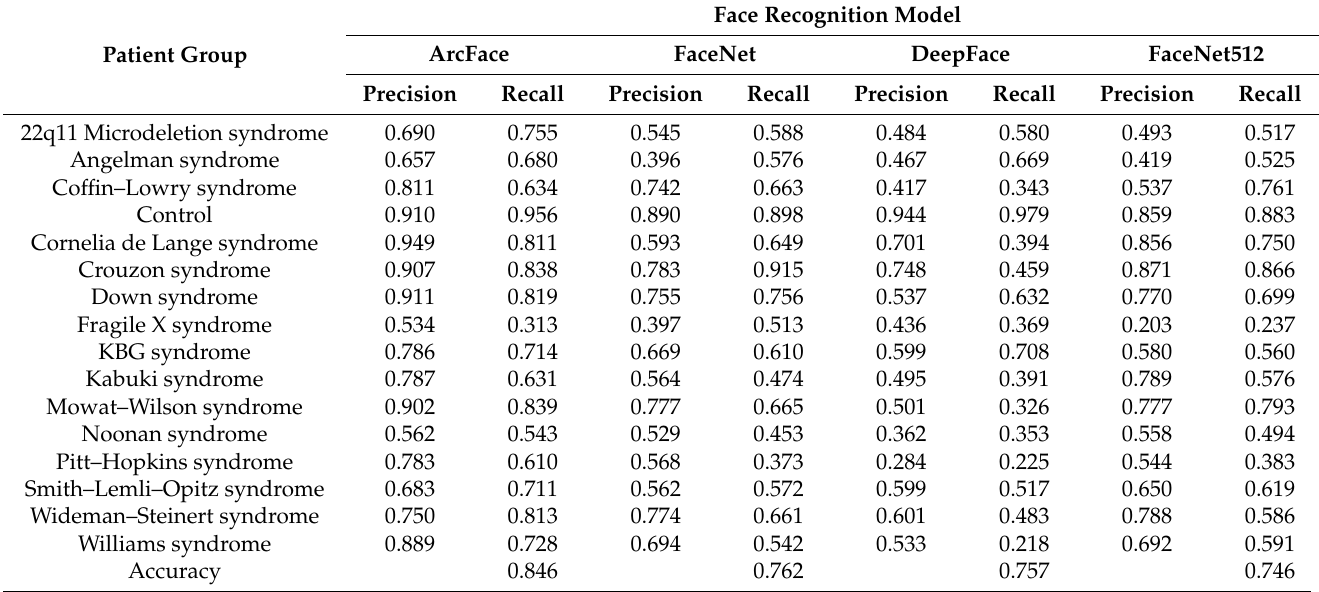
Table 2. Result of multiclass classification for 4 most accurate face recognition models.